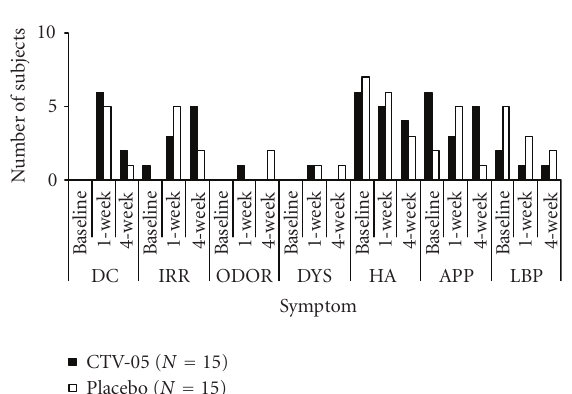
Figure 2: Symptoms reported by ≥ 2 women at clinic visits ( P > . 05 for comparison of L. crispatus CTV-05 to placebo at all visits). CTV- 05, L. crispatus CTV-05; DC, abnormal vaginal discharge; IRR, ex- ternal genital or vaginal irritation; ODOR, vaginal odor; DYS, dy- suria; HA, headache; APP, abdominal or pelvic pain/cramps; LBP, low back